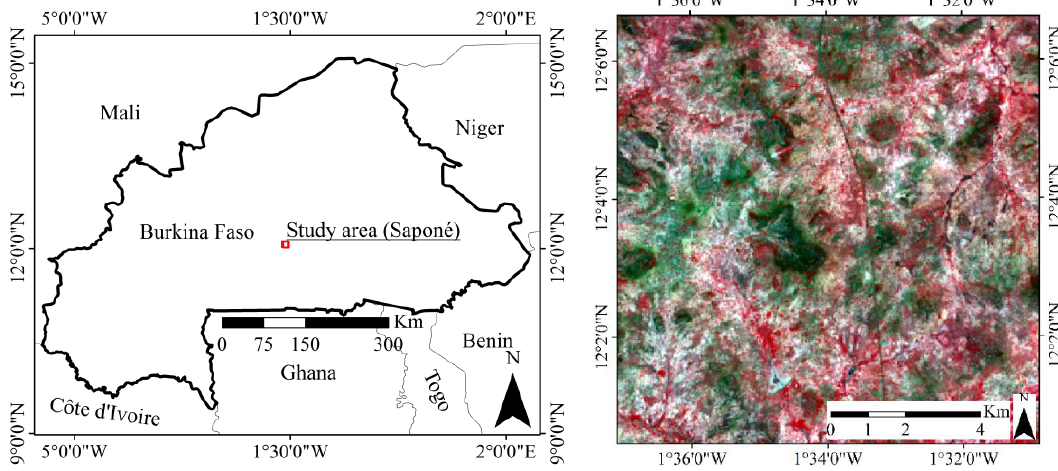
Figure 1. Map showing the location of the study area in central Burkina Faso ( left ). False color composite (red: Band 5; green: Band 4; blue: Band 3) of wet season Landsat data ( right